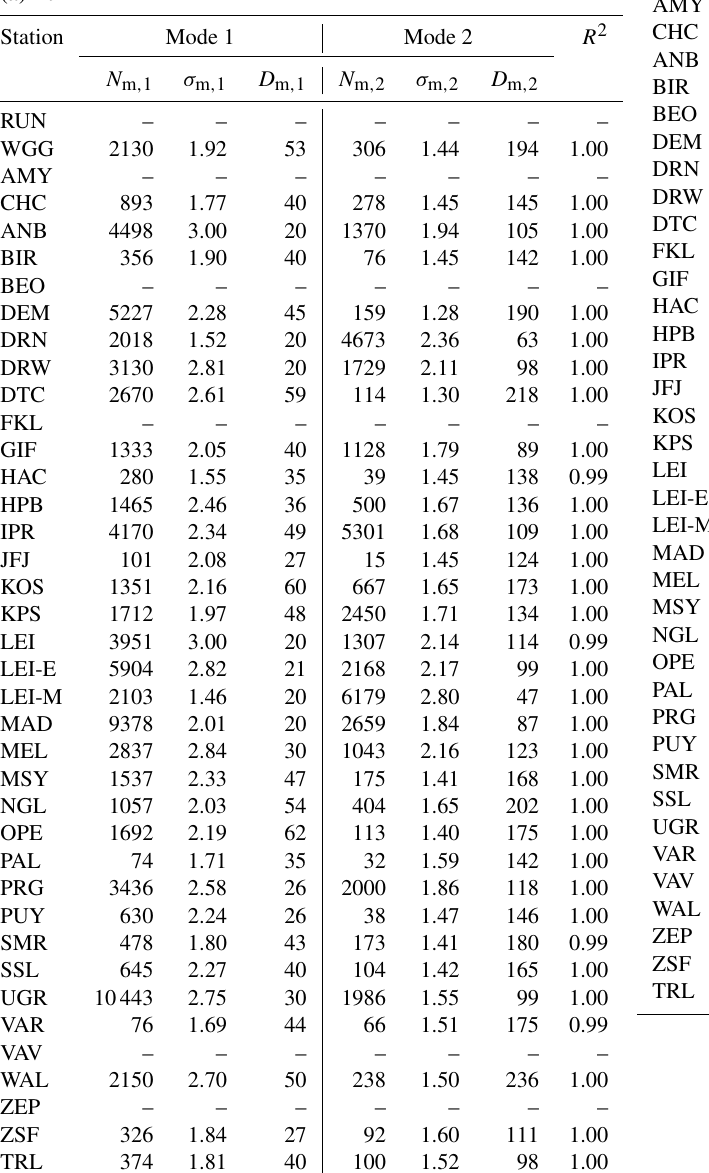
Table A1. Parameters of the modes identified for the description of the median particle number size distributions measured at the stations equipped with an MPSS. N m , σ m and D m are the number concentration, the geometric standard deviation and the geometric mean dry diameter of the mode, respectively. R 2 is the coefficient of determination between observed and fitted size distributions. The results are reported separately for each